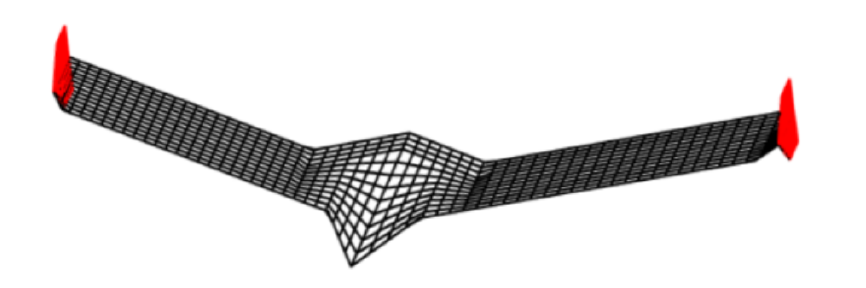
Figure 12. Aerodynamic grid of the Mini MUTT aircraft